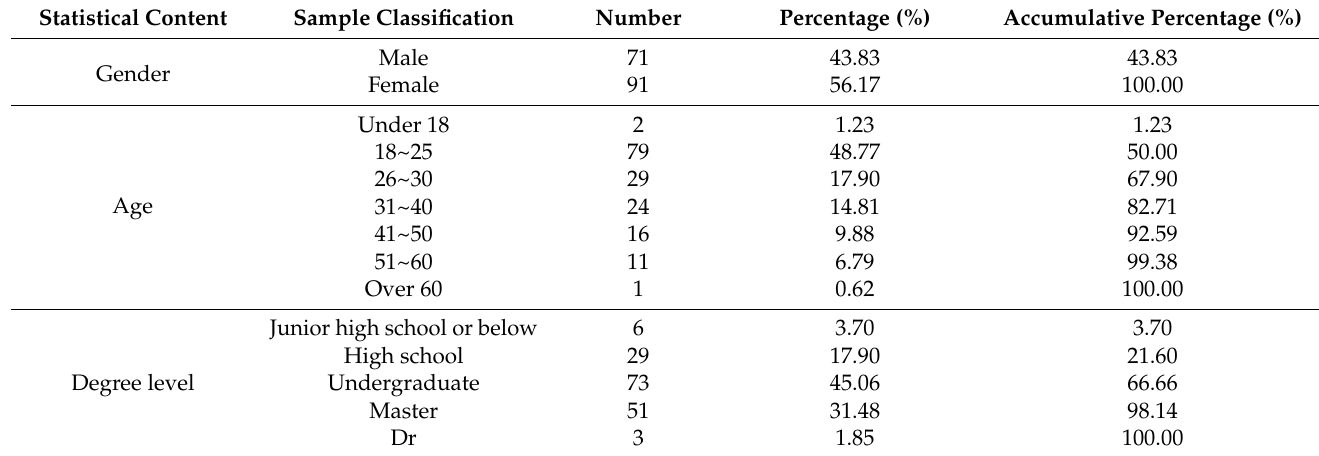
Table 1. Demographic data analysis of the initial scale measurements.